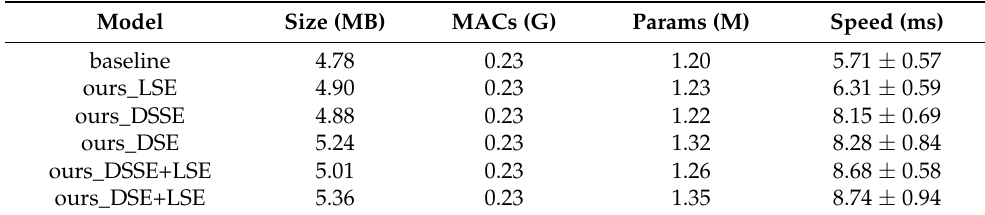
Table 6. Performance comparison of different models.